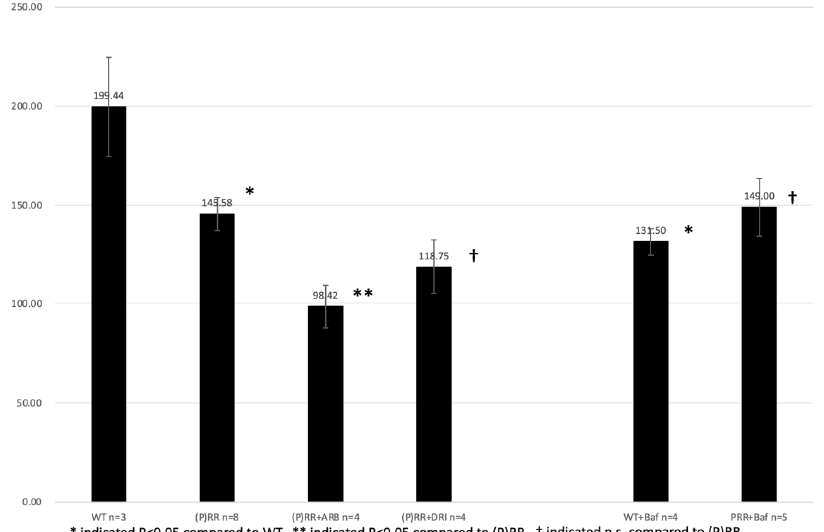
Figure 10. Average urine Na + excretion of animals is shown. Data were analyzed using one-way ANOVA between (P)RR mice and t -test between WT and (P)RR mice. ANOVA between (P)RR mice and t -test between WT and (P)RR mice.